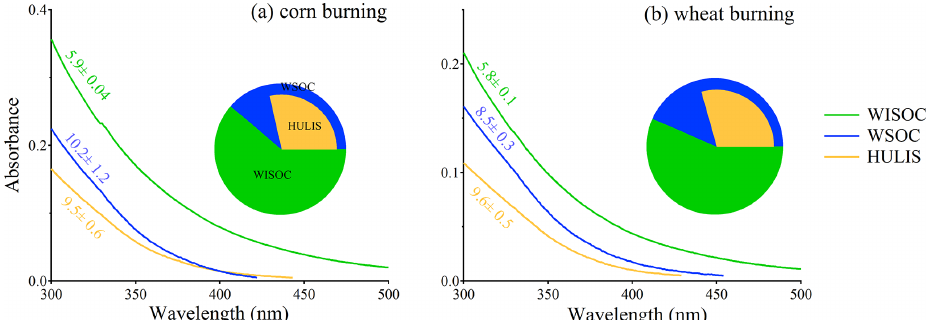
Figure 5. UV–Vis spectra of carbonaceous aerosol solutions, including WSOC, HULIS C and WISOC, from (a) corn and (b) wheat burning experiments. The pie chart in each panel is the absorption contribution of different BBOA fractions at 300nm. The number represents the average AAE of each BBOA fraction derived from the absorption in the wavelength range of 300–450nm.